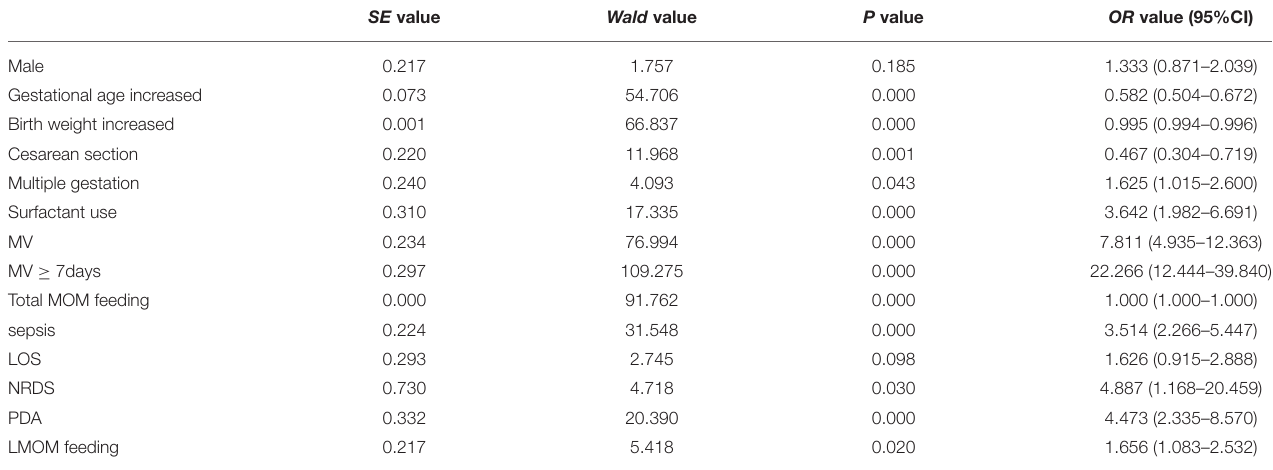
TABLE 3 | Univariate logistic regression analysis of the factors affecting moderate and severe BPD.